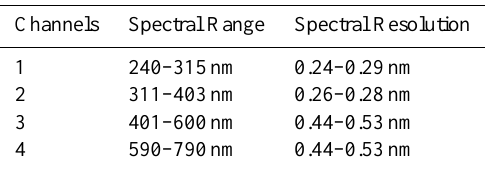
Fig. 2. GOME-2 FM3 temperature dependent absorption cross sec- tion spectra in the Hartley band. Table 1. Spectral ranges and resolutions of each channel of the GOME-2